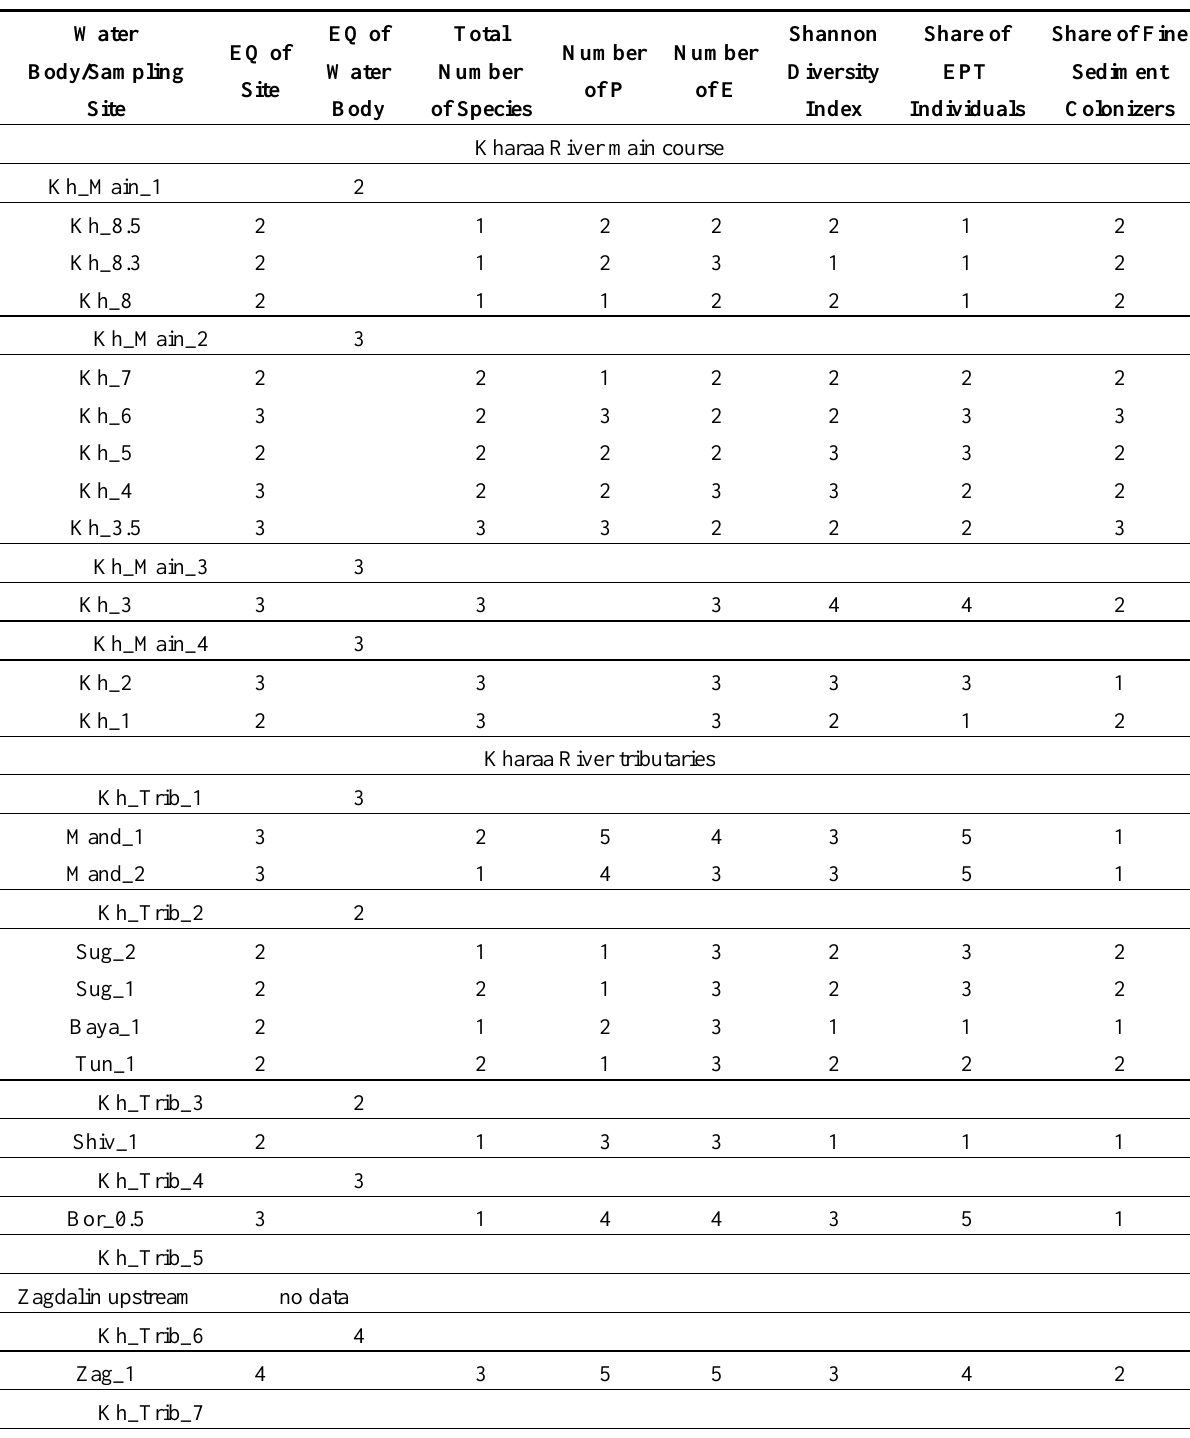
Table 9. The ecological assessment of the Kharaa River, using the benthic invertebrate community. The table shows ecological quality metrics on a five step scale with 1 being “very good” and 5 being “bad” (EQ = Ecological quality. E = Ephemeroptera = mayflies. P = Plecoptera = stoneflies. T = Trichoptera =